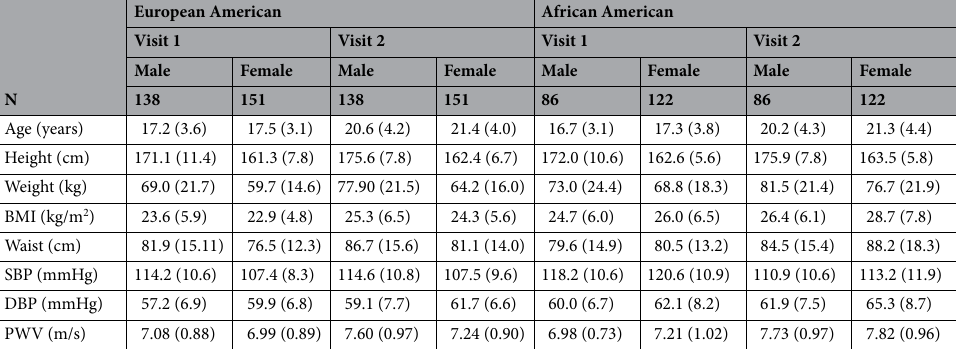
Table 1. General characteristics of study participants by visit, ethnicity and gender. Data were present as mean (SD). All variables showed significant increase from visit 1 to visit 2 with p < 0.001.